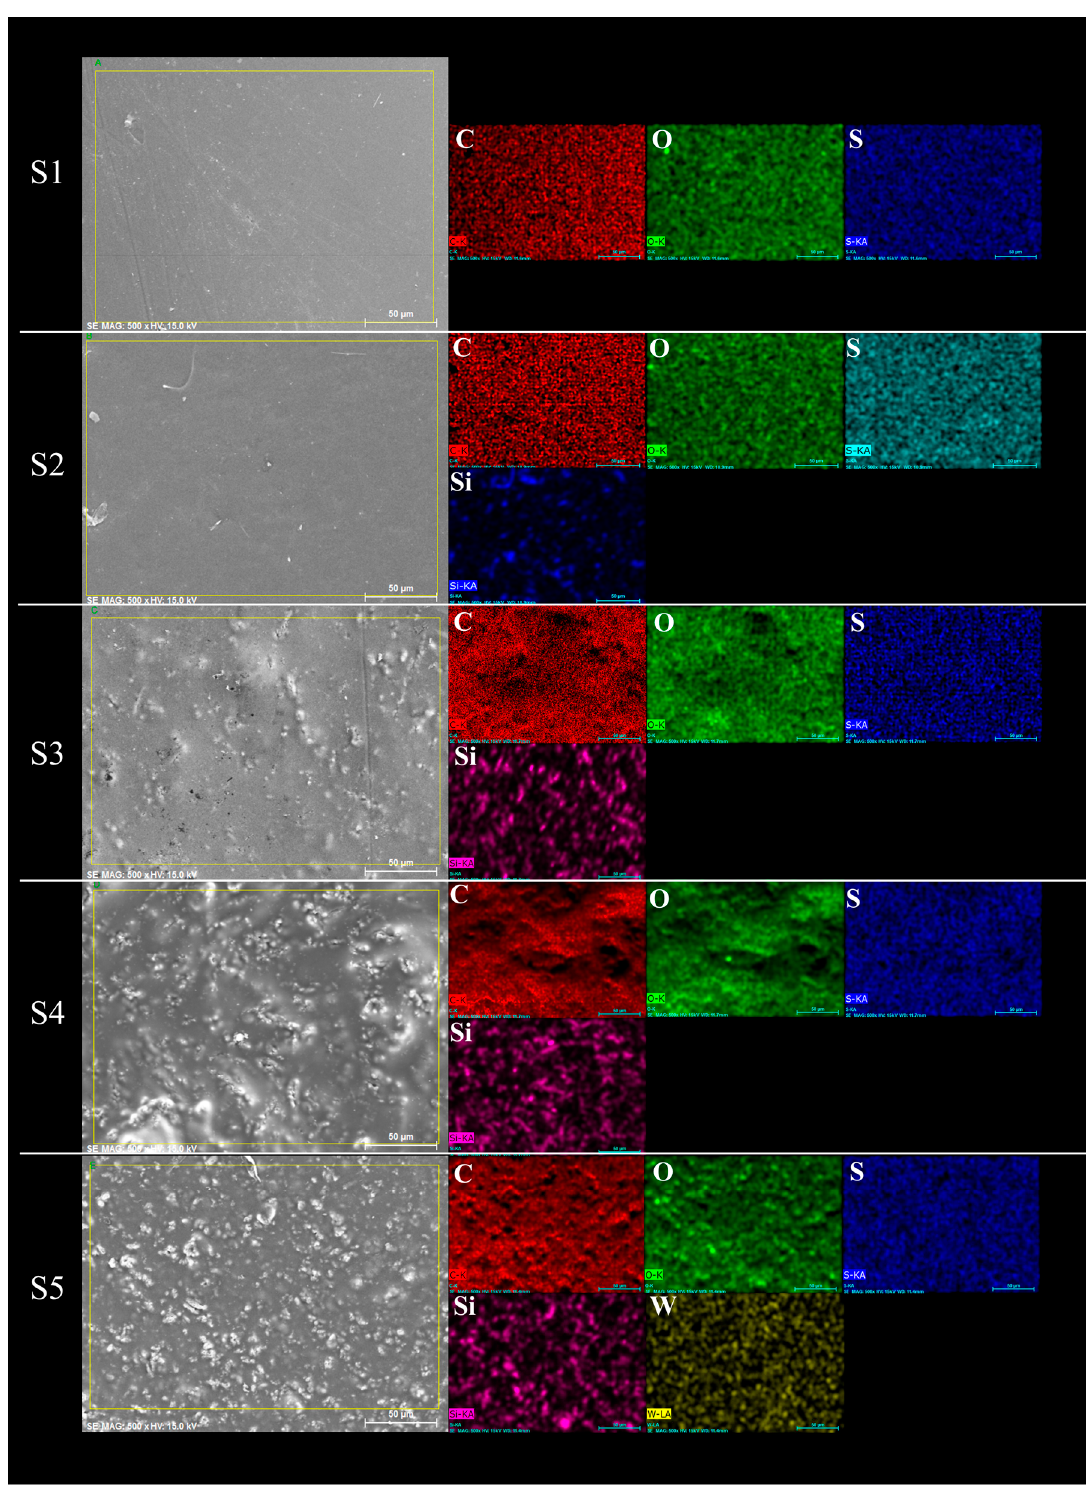
Figure 3. Morphologies of the different membranes investigated by SEM-EDS.